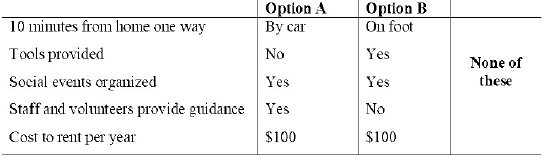
Fig 2. An example of a choice